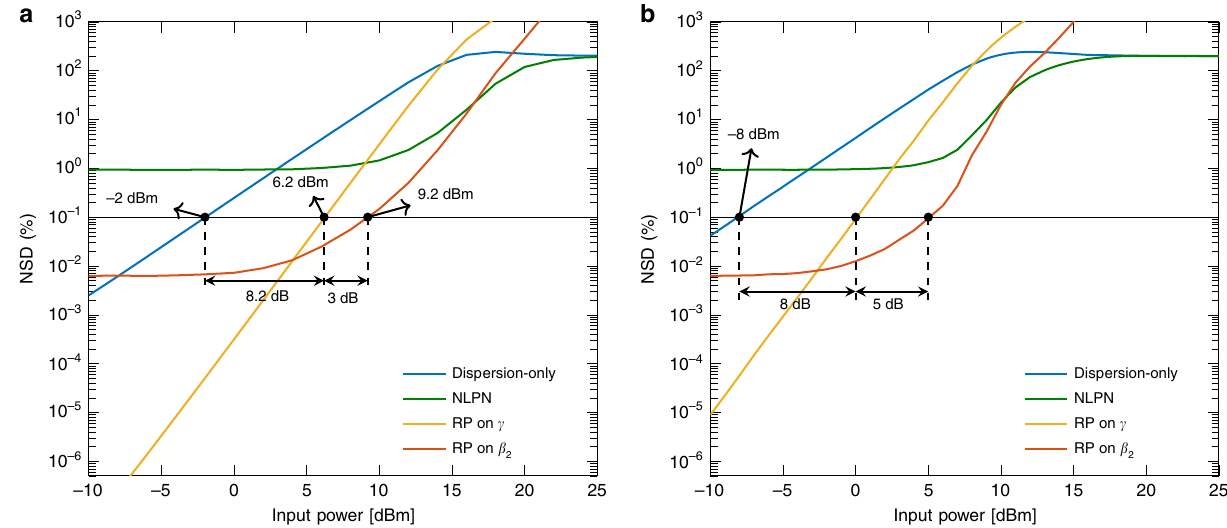
Fig. 4 NSD for the four models in 80 km of an NZDSF. a With attenuation ( α = 0.22 dB km − 1 ). b Without attenuation ( α = 0 dB km − 1 ). The power gap in dB between the NSD curves is related to different input powers that allow each model to achieve 0.1% NSD. In the system without attenuation b , this gap is increased when comparing RP on γ with RP on β 2